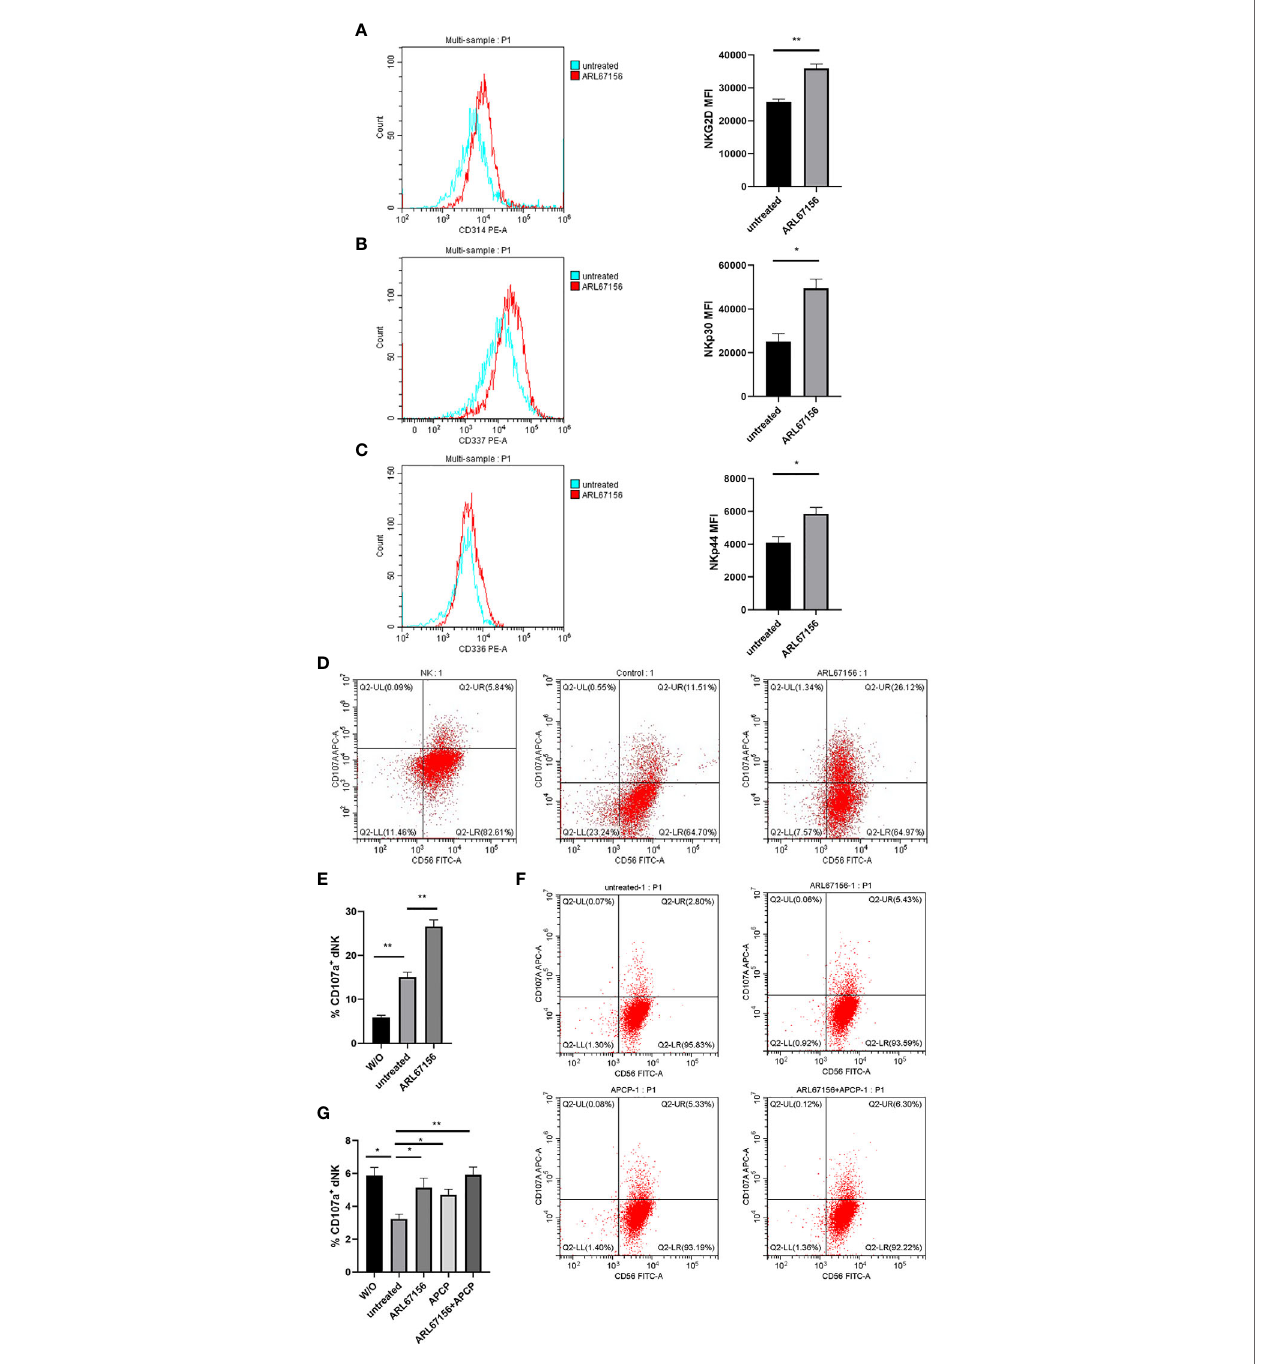
FIGURE 5 | The cytotoxicity of dNK cells was regulated by CD39/CD73 enzyme activity. (A – C) Freshly isolated dNK cells from healthy donors were incubated in the absence or presence of the CD39 inhibitor ARL67156 for 24 hours, and then stained for the surface expression of the cytotoxicity markers NKG2D (A) , NKp30 (B) and NKp44 (C) . All experiments were performed in triplicate (mean ± SEM, *P < 0.05, **P < 0.01 by two-tailed t tests). (D, E) Effects of CD39 on the degranulation of activated dNK cells from healthy donors. To quantify degranulation, the surface expression of CD107a was measured after activation of isolated dNK cells were incubated with or without (W/O) the NK-susceptible target cell line (K562 cells) in the absence or presence of the CD39 inhibitor ARL67156 for 24 hours (mean ± SEM, **P < 0.01 compared with the untreated group, one-way ANOVA and post hoc tests). (F, G) dNK cells isolated from healthy donors co-cultured with HTR-8/ SVneo cells (dNK : HTR-8/SVneo cells = 2:1) in the absence or presence of the CD39 inhibitor ARL67156 and/or CD73 inhibitor APCP for 24 hours. The percentage of dNK cells expressing CD107a was used as the indicator of degranulation (mean ± SEM, *P < 0.05, **P < 0.01, one-way ANOVA and post hoc